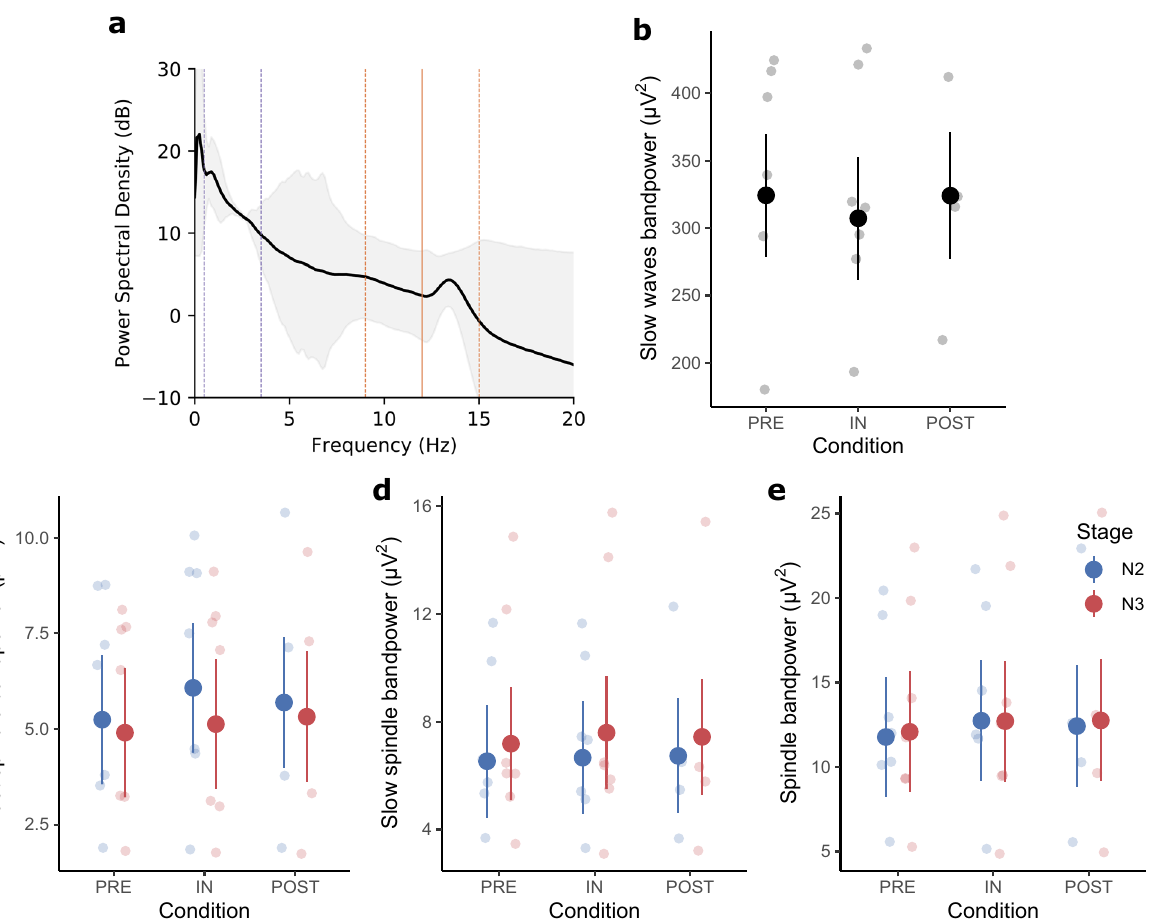
2.55.07.5 Fig. 1 Power spectral density analyses in N2 and N3. a Power spectral density: The thick black line represents the average power across all channels, conditions, sessions, and subjects across N2 and N3, while the shaded gray area indicates the standard error. A solid orange line separates the a priori de fi ned slow spindle (9 – 12 Hz) and fast spindle (12 – 15 Hz) ranges. Two dashed orange lines show the lower-bound (9 Hz) and upper-bound (15 Hz) of the total spindle frequency band. A clear PSD increase can be observed for frequencies of around 13.5 Hz. Two purple dashed lines indicate the a priori de fi ned slow wave band (0.5 – 3.5 Hz). b Slow wave band-power: was calculated by integrating over the slow wave band in ( a ) and fi nally used in a linear mixed-effects model to evaluate statistical differences between conditions. c Fast spindle band-power: was calculated similar to ( b ). d Slow spindle band-power: was calculated similar to ( b ). e Overall spindle band-power: was calculated similar to ( b ). For b , c , d , and e the large dots represent the estimated marginal means (± standard error) of each condition separated for stages N2 and N3 in the spindle analyses. The smaller dots in the background are individual data Condition × Stage: F (2,26) = 2.32, p = 0.12; Melatonin: F (1,26.04) = Fast spindle densities signi fi cantly differed between the 0.00, p = 0.98). conditions ( F (2,26) = 5.92, p < 0.01; Fig. 2a) and stages ( F (1,26) = 69.98, p < 0.01; Supplementary Table 1). Post hoc tests revealed Fig. 2d and Supplementary Table 5) of fast spindles across all that fast spindle density signi fi cantly increased by 1.76 ± conditions, however, all other factors had no signi fi cant effect 0.53 spindles/min in fl ight compared to pre fl ight (Table 1). The (Condition: F (2,26.00) = 1.48, p = 0.25; Condition × Stage: interaction Condition × Stage ( F (2,26) = 2.71, p = 0.09) and F (2,26.00) = 0.27; p = 0.77, Melatonin: F (1,26.25) = 2.25, p = 0.15). Melatonin were not signi fi cant ( F (1,26.07) = 0.43, p = 0.52). Slow spindle density (Fig. 3a) did not signi fi cantly differ Fast spindle amplitude (Fig. 2b) was not affected by Condition between conditions ( F (2,26) = 3.13, p = 0.06), and was not ( F (2,26) = 3.05, p = 0.06), the Condition × Stage interaction ( F (2,26) = 0.02, p < 0.98) nor Melatonin ( F (1,26.02) = 1.92, p = 0.18). Stage affected by the Condition × Stage interaction ( F (2,26) = 0.47, was the only factor that signi fi cantly modulated fast spindle p = 0.63). Slow spindle density was signi fi cantly affected by Stage amplitude ( F (1,26) = 17.70, p < 0.01; Supplementary Table 2). ( F (1,26) = 50.20, p < 0.01; Supplementary Table 11) and Melatonin Spectral band-power in the fast spindle range (Fig. 1c) only ( F (1,26.08) = 7.36, p = 0.01; Supplementary Table 12). deviated signi fi cantly between sleep stages ( F (1,26) = 7.91, p < For slow spindle amplitude only the factor Stage was 0.01; Supplementary Table 3) all other factors were non-signi fi cant signi fi cant ( F (1,26) = 19.43, p < 0.01; Fig. 3b and Supplementary (Condition: F (2,26) = 3.24, p = 0.06; Condition × Stage: F (2,26) = Table 13), while all other factors had no signi fi cant effect (Condition: F (2,26) = 1.63, p = 0.22, Condition × Stage: F (2,26) = 1.18, p = 0.32; Melatonin: F (1,26.02) = 2.31, p = 0.14). 0.03, p = 0.97, Melatonin: F (1,26.03) = 3.22, p = 0.08). Fast spindle duration (Fig. 2c) was only affected by Stage Slow spindle band-power (Fig. 1d) was neither affected by ( F (1,26) = 141.61, p < 0.01; Supplementary Table 4), while all other Condition ( F (2,26) = 0.22, p = 0.80), Stage ( F (1,26) = 3.90, p = 0.06), factors were non-signi fi cant (Condition: F (2,26) = 0.68, p = 0.52;